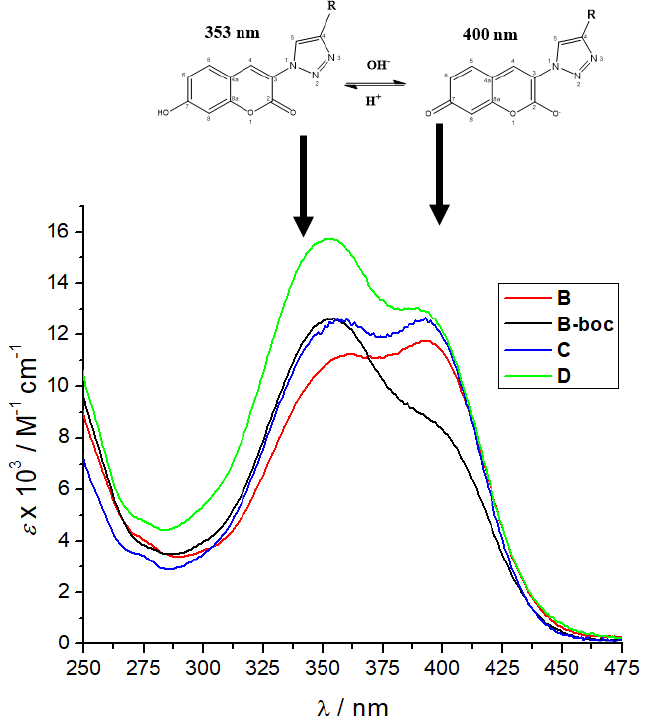
Figure 2. Comparison of UV spectra B , B-boc , C and D at pH 7, sodium cacodylate buffer, c = 50